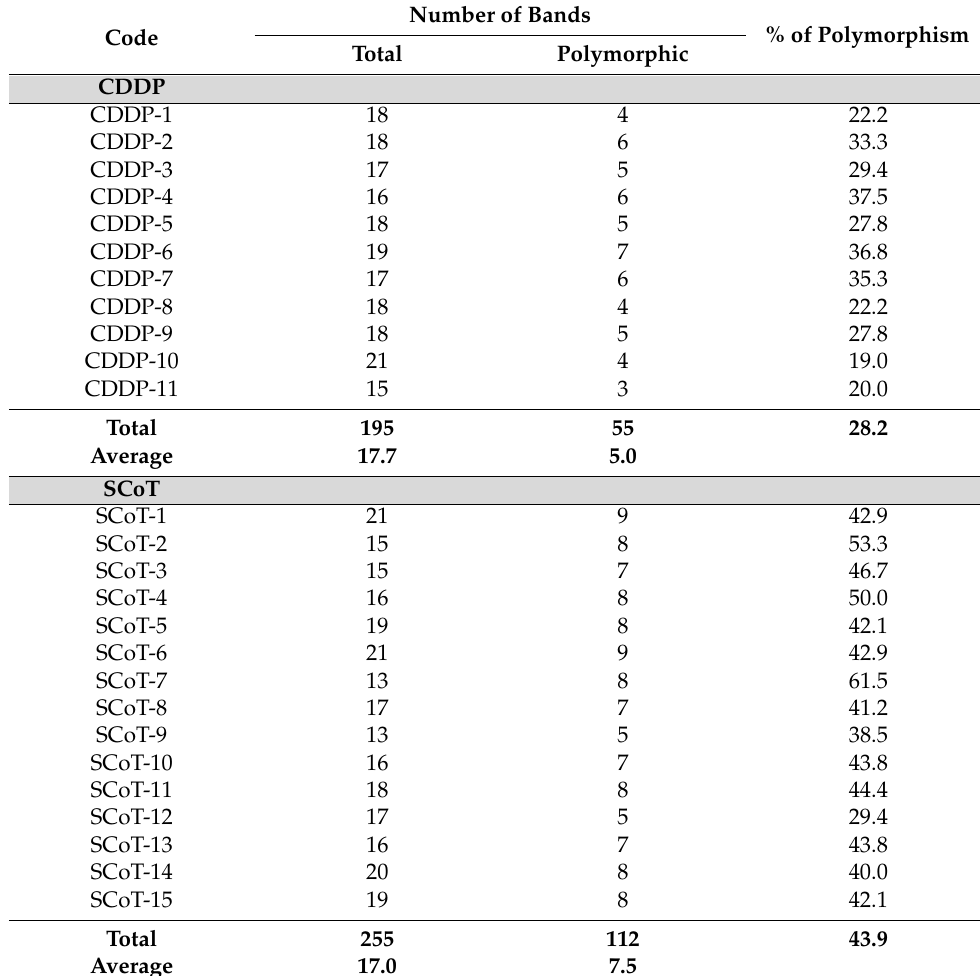
Table 3. Primer code, the total number of bands, number of polymorphic bands, and percentage of polymorphism in the CDDP and SCoT